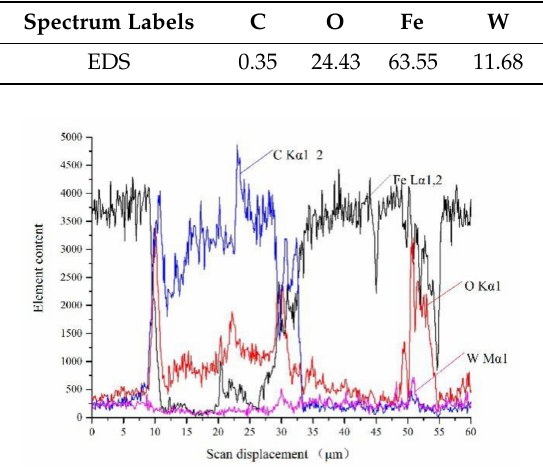
Figure 23. It is the EDS data of Figure